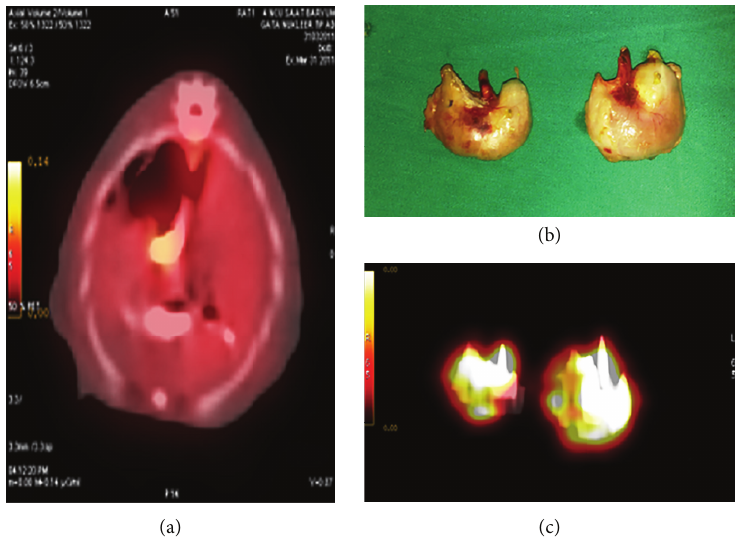
Figure 2: PET/CT image demonstrated the presence of the activity that can be interpreted as to be the activity of the labeled stem cells in the lower portion of the esophagus containing barium sulphate (a). Esophagogastric junction was resected (b) and imaged (c) by PET/CT to delineate the prominent activity in the lower portion of the injured esophagus.